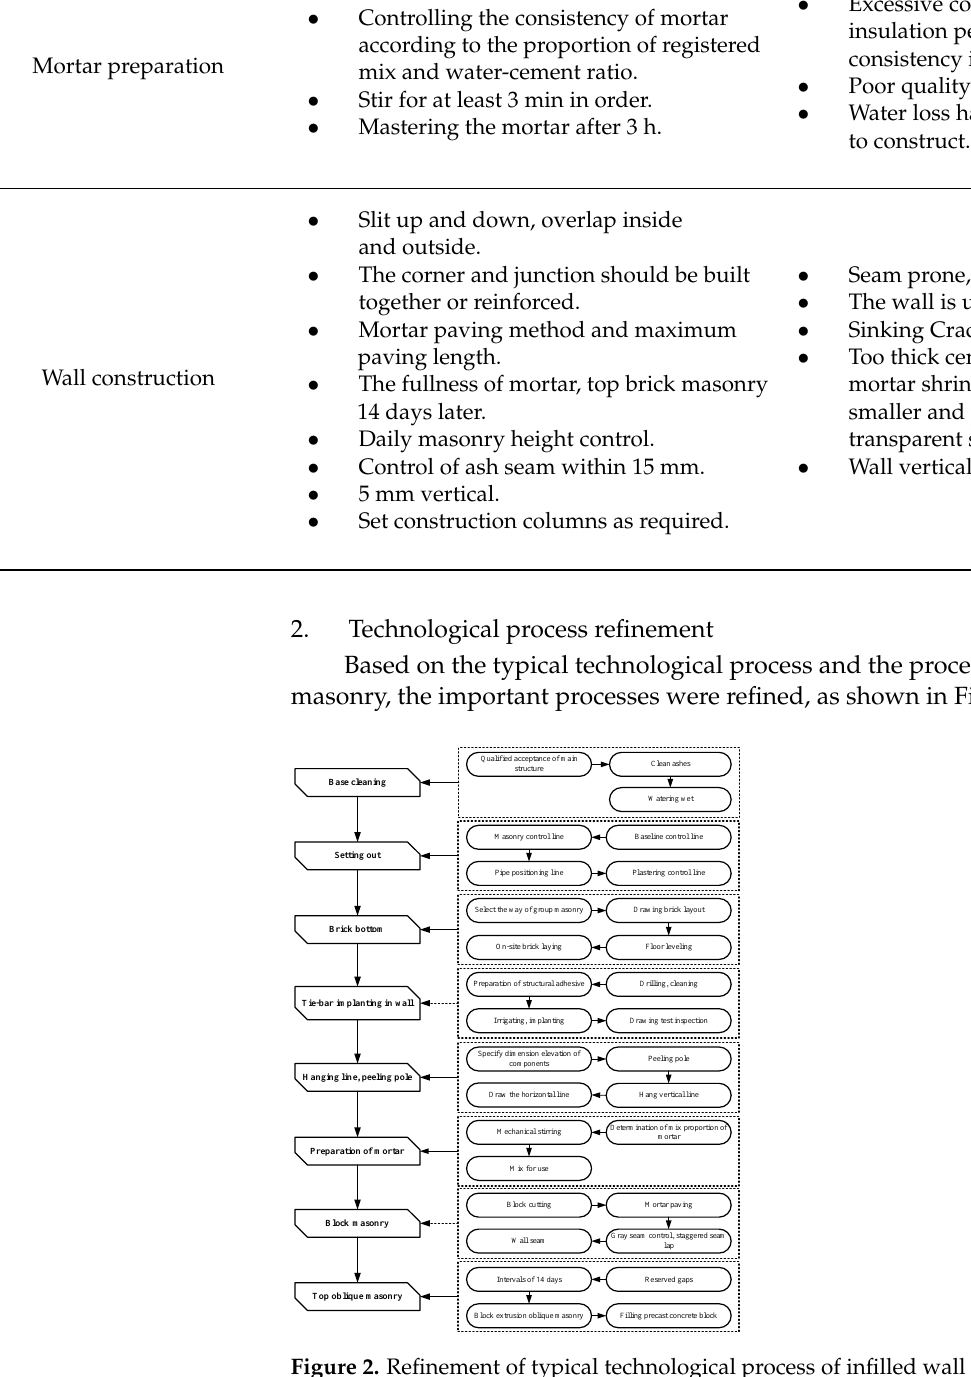
Figure 2. Refinement of typical technological process of infilled wall masonry.